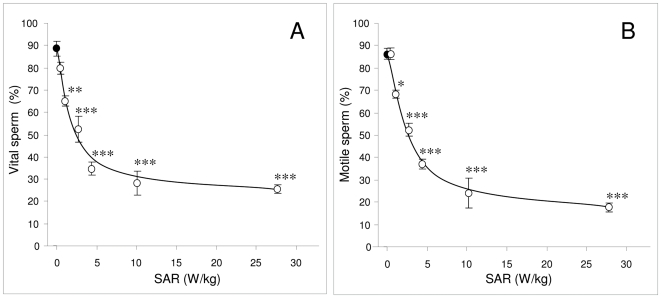
RF-EMR exposure reduces motility and vitality of human spermatozoa, in an SAR dependent manner.Percoll-purified spermatozoa (5×106 cells) were suspended in 1 ml BWW in a 35 mm Petri dish and placed within the waveguide while control cells (closed circles) were placed outside the waveguide. Cells in the waveguide were exposed to 1.8 GHz RF-EMR at SAR levels of 0.4, 1.0 2.8 4.3 10.1 and 27.5 W/kg (open circles) for 16 h at 21°C. Both vitality and motility were reduced in a dose dependent manner. A, Vitality was significantly reduced at a SAR of 1.0 W/kg from 89%±3% to 65%±1% (**p<0.01). B, Motility was also significantly reduced at a SAR of 1.0 W/kg from 86%±2% to 68%±2% (*p<0.05). All results are based on 4 independent samples.